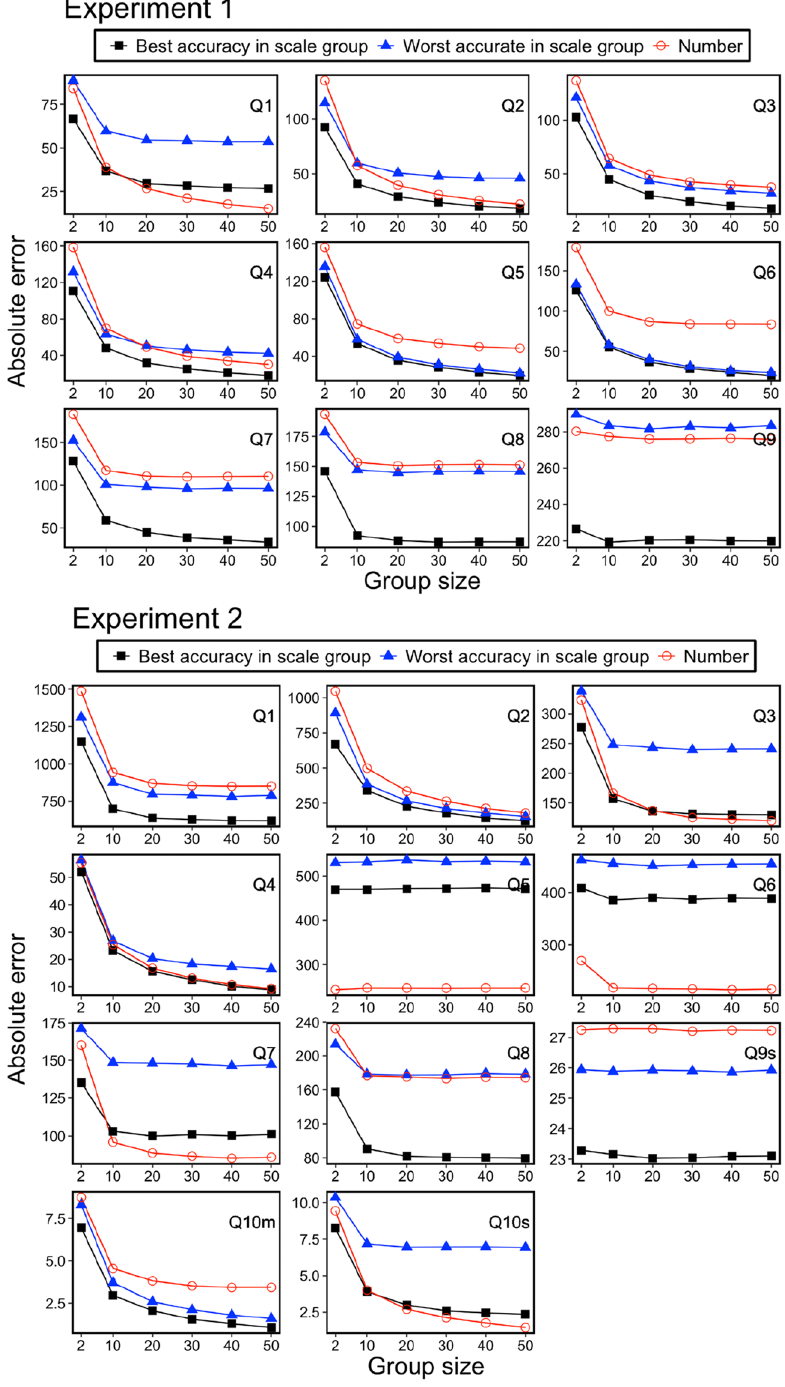
Figure 7. Mean of absolute error (difference between group performances and correct answers) for 5000 computer simulations as a function of group